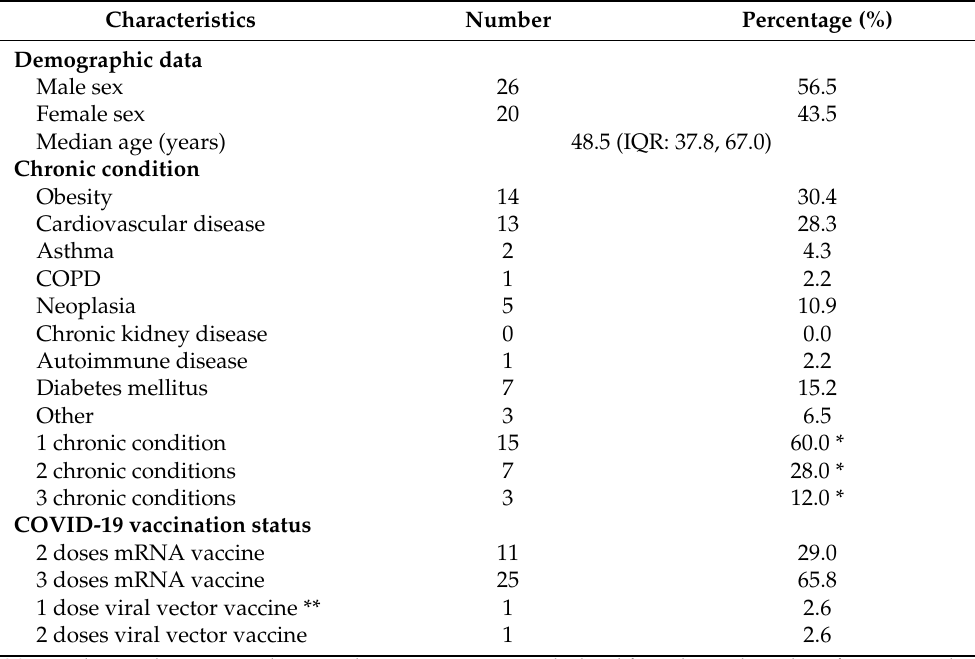
Table 1. Distribution of chronic conditions in patients treated with